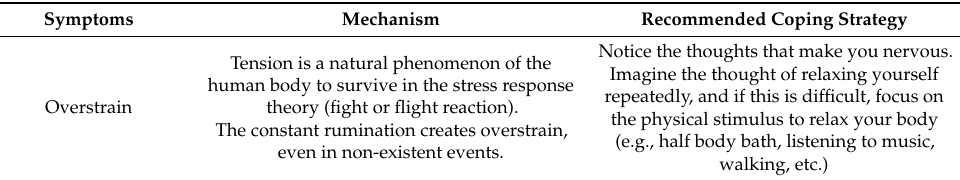
Table 2. Guidance for symptom